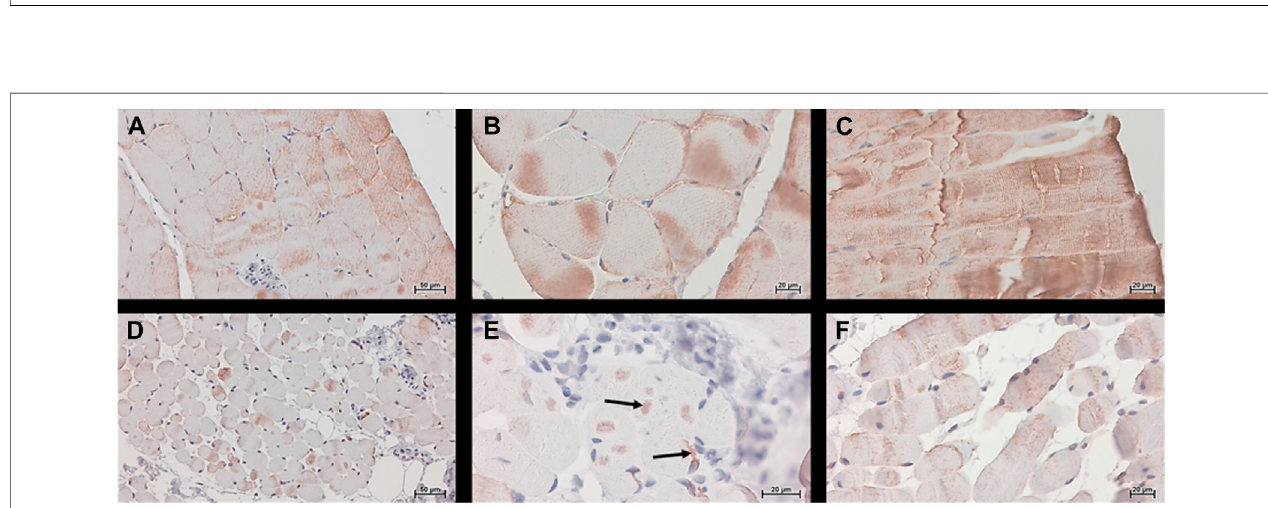
FIGURE 6 | Desmin was detected histochemically, using the Histostain ® -Plus third Gen IHC Detection Kit, which revealed desmin (brown color) in CTR (panels A – C )andMUT(panels D – F )muscles. (A,D) Magni fi cation×200;scalebar50 μ m; (B,C,E,F) magni fi cation×400;scalebar20 µm.Desminwaspresentinthecytoplasm and inthesarcoplasmic membrane oftheCTRmuscle.InMUTmuscle,desmin appeared atlowerlevels than intheCTRmuscleinthesarcoplasmandasaggregates in paracentral and peripheral locations (examples indicated by arrows on panel E ). The banding pattern typical of normal muscle in longitudinal section (panel C ) was absent in the muscle from the patient (panel F